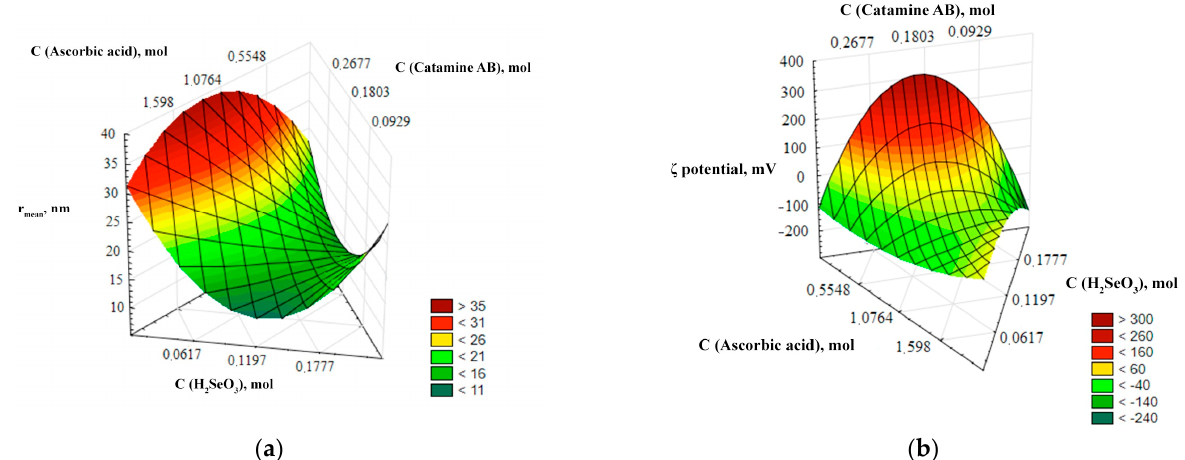
Figure 2. Ternary surfaces describing the relationship with the average hydrodynamic radius ( a ) and ζ -potential ( b ) of Se NPs.